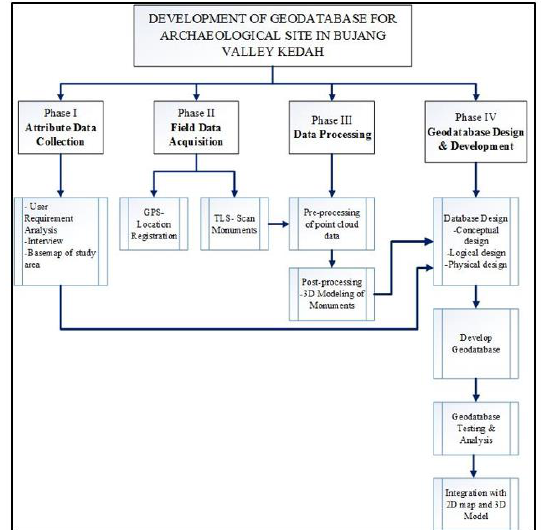
Figure 1: The flowchart of the Development of Geodatabase for Archaeological Site in Bujang Valley,